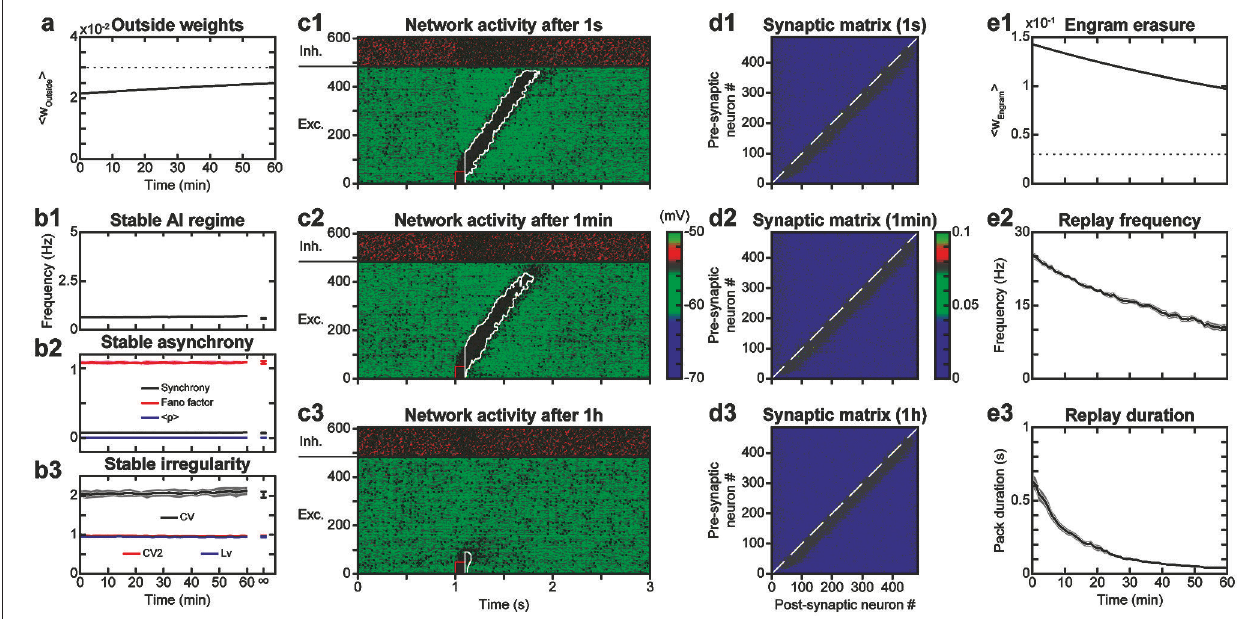
FIGURE 6 | Stability of the spontaneous AI regime in the presence of the engram. (A) . Average synaptic weights outside the engram after learning for 1h. Shaded areas represent 95% confidence intervals of the mean for 5 network simulations. (B) . Networks dynamics after learning for 1 h: frequency (B1) , synchrony (B2) , and irregularity (B3) of excitatory neurons. Shaded areas as in (A) . (C) . Membrane potential of neurons in the neural network for 3s following a replay stimulation of the 50 first neurons at 1s (C1) , 1min (C2) or 1h (C3) after trajectory learning. (D) Synaptic matrices between excitatory neurons of the network, at the end of the simulations presented in (C) . (E) Network engram synaptic weight average (E1) as well as frequency (E2) and duration (E3) of trajectory replays during 1h after trajectory learning. Shaded areas as in (A)